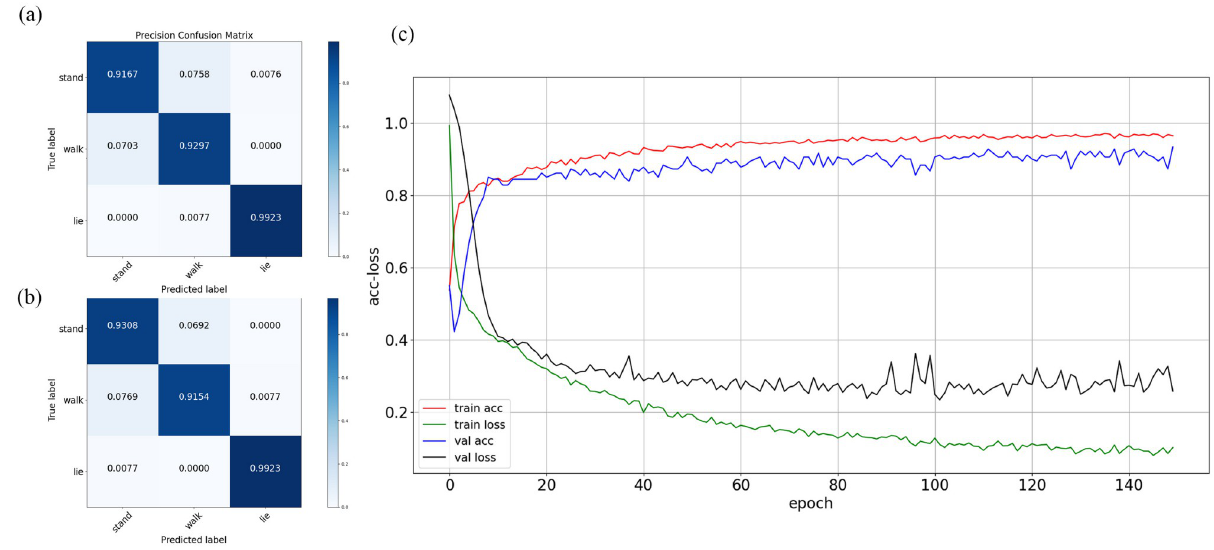
Fig 7. Matrix of (a) precision and (b) Recall ratio. (c) Average accuracy and loss function